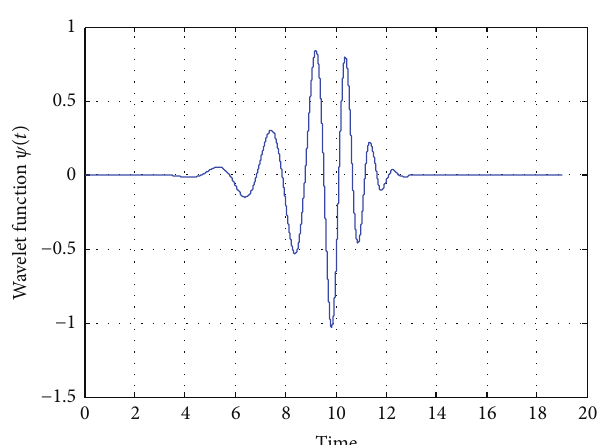
Figure 12: Daubechies basis function